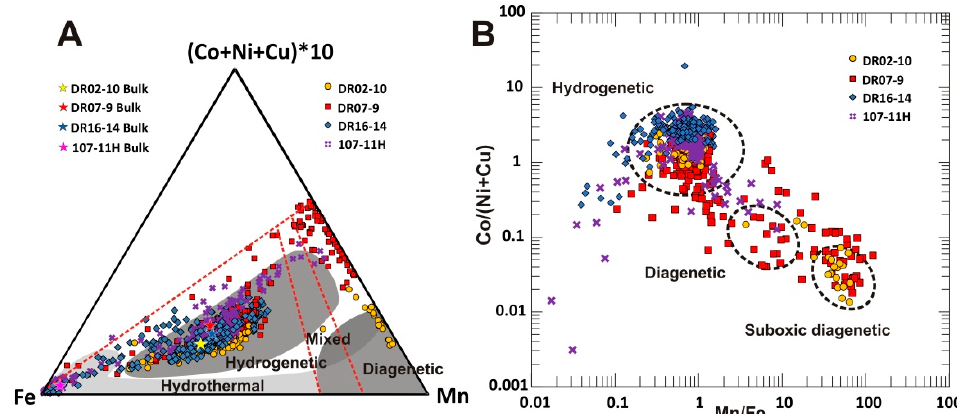
Figure 12. ( A ) EPMA spots analysis plotted in the ternary diagram from [27] to differentiate genetic processes of the Fe-Mn oxides, light grey field hydrogenetic, medium grey hydrothermal and dark grey diagenetic, modified according [6] and [33], discontinuous red lines, to better differentiate the genetic fields; ( B ) the same EPMA analysis plotted in the binary diagram according [28] to differentiate diagenetic or suboxic diagenetic fields.